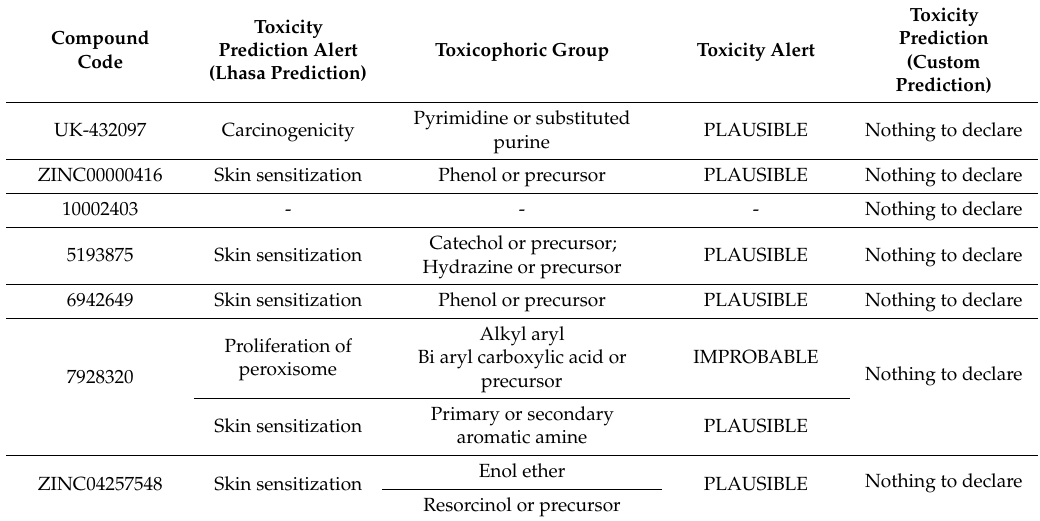
Table 8. Toxicity prediction for UK-432097 and compounds selected by virtual